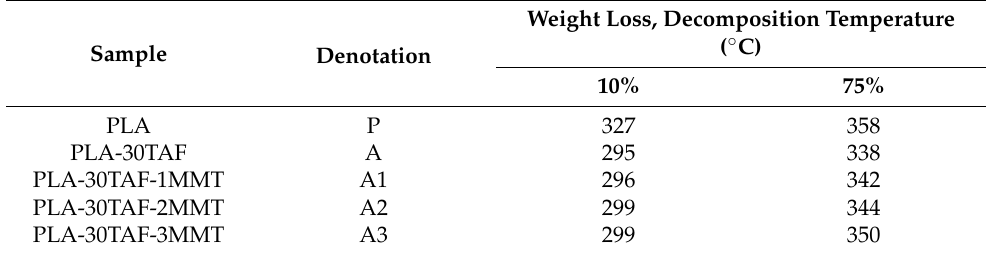
Table 4. TGA analysis sample of MMT clay reinforced treated aloe vera fiber/PLA hybrid